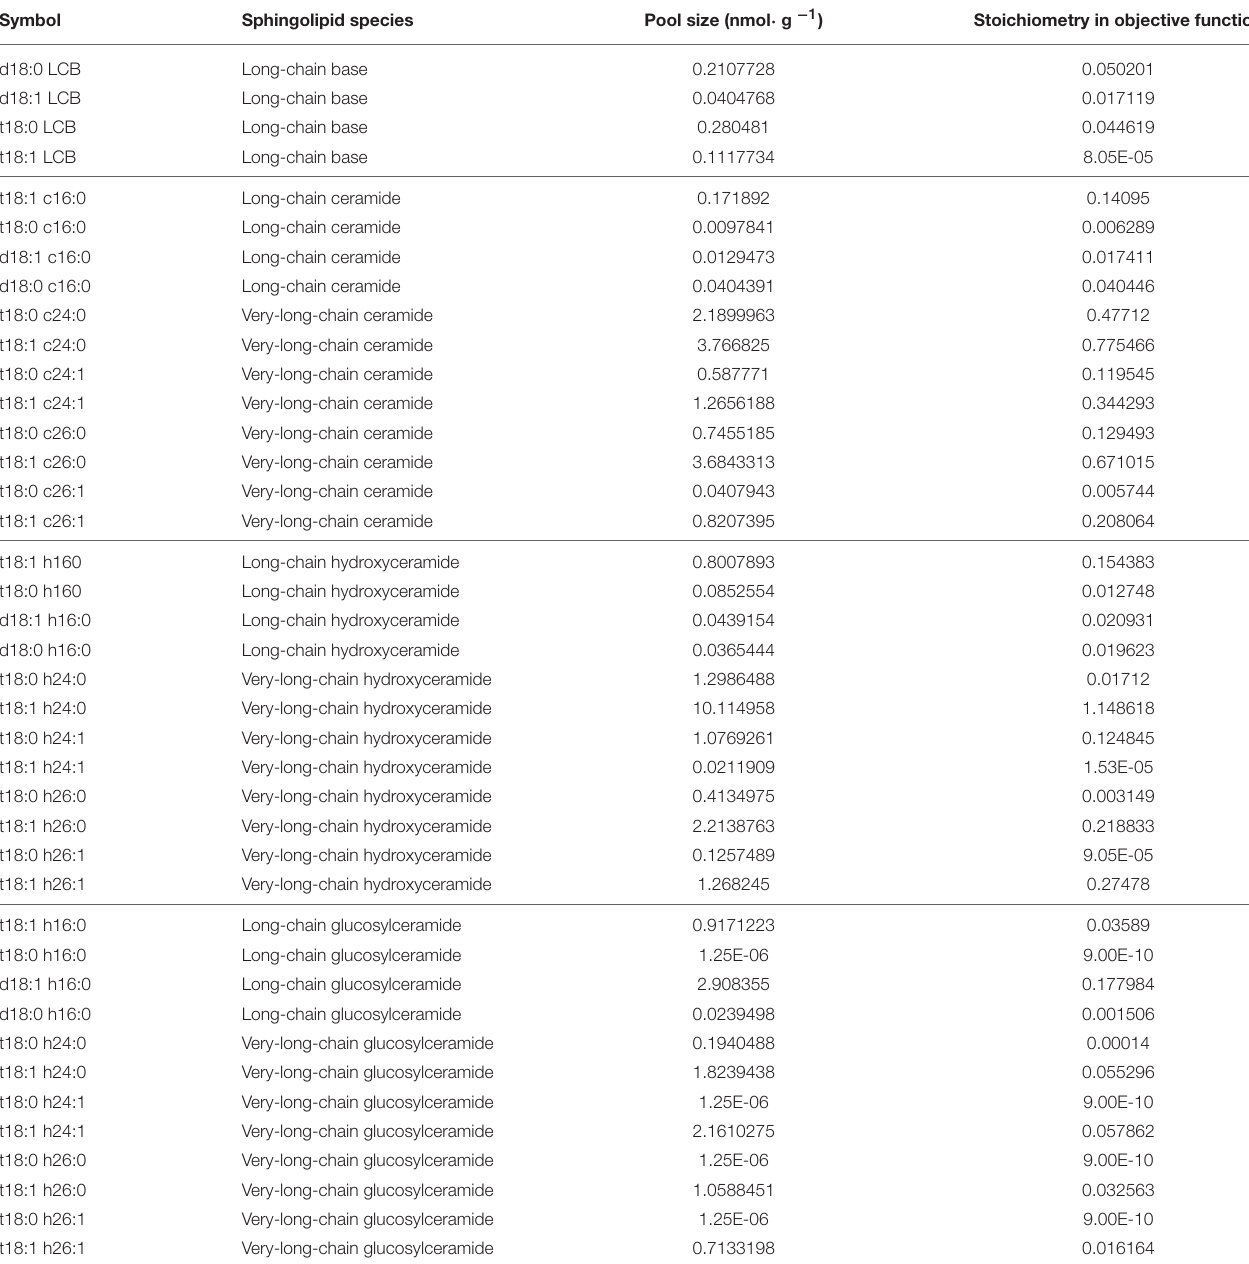
TABLE 1 | Overview of sphingolipid species in the FBA model. Symbol Sphingolipid species Pool size (nmol · g − 1 ) Stoichiometry in objective